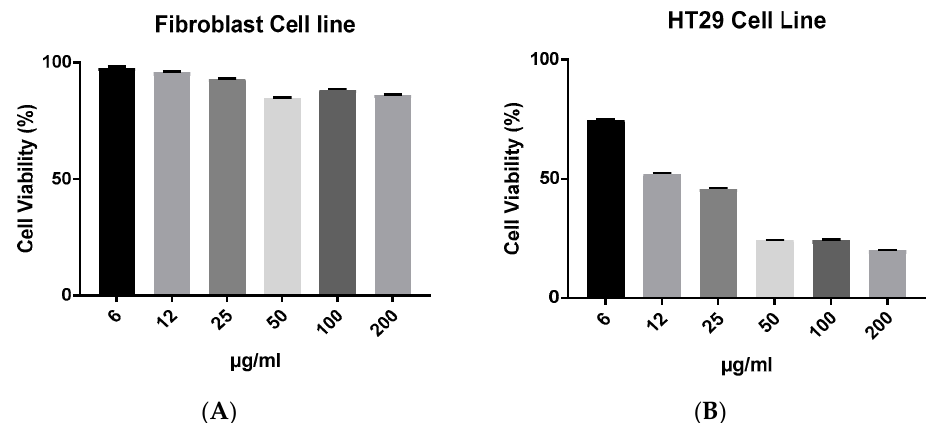
Figure 6. The effect of AgNPs at 6 µg/mL with biochar at 6 to 200 µg/mL on the viability of ( A ) fibroblasts and ( B ) HT29 cell line in 72 h cultures as measured by an MTT assay. The results are expressed as means of three measurements ± SD ( n = 3–4 independent replicates).